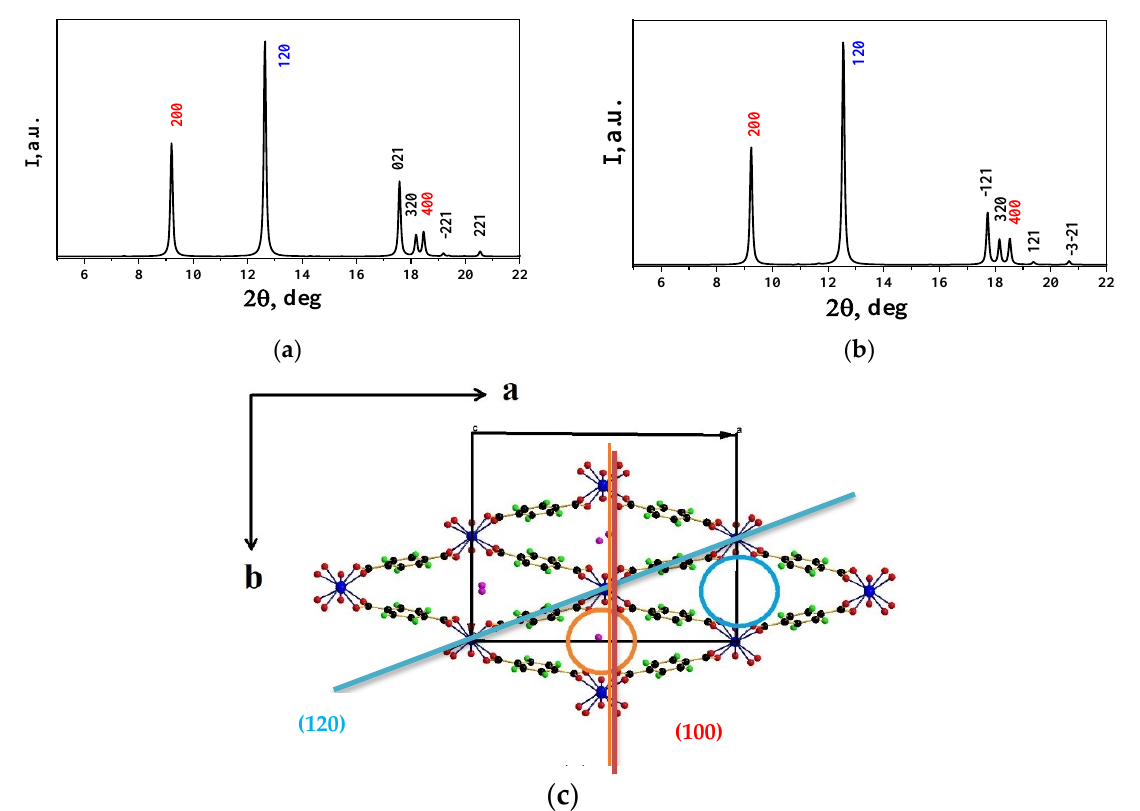
Figure 5. Structure V (sp.gr. P 1 2 1 /c 1; z = 8) or superstructure to structure III (sp.gr. C 1 c 1 or C 1 2/c 1; z = 4): theoretical